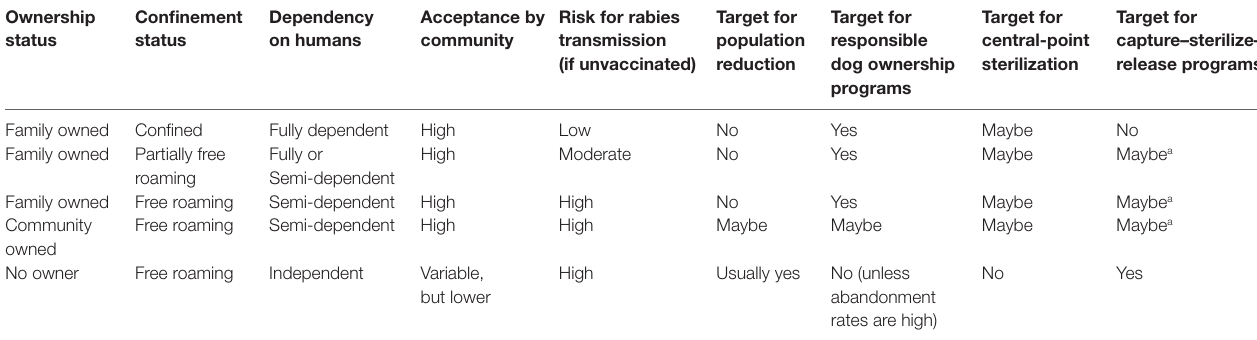
TABLe 2 | Different sub-populations of dogs and factors relevant to dog population management.